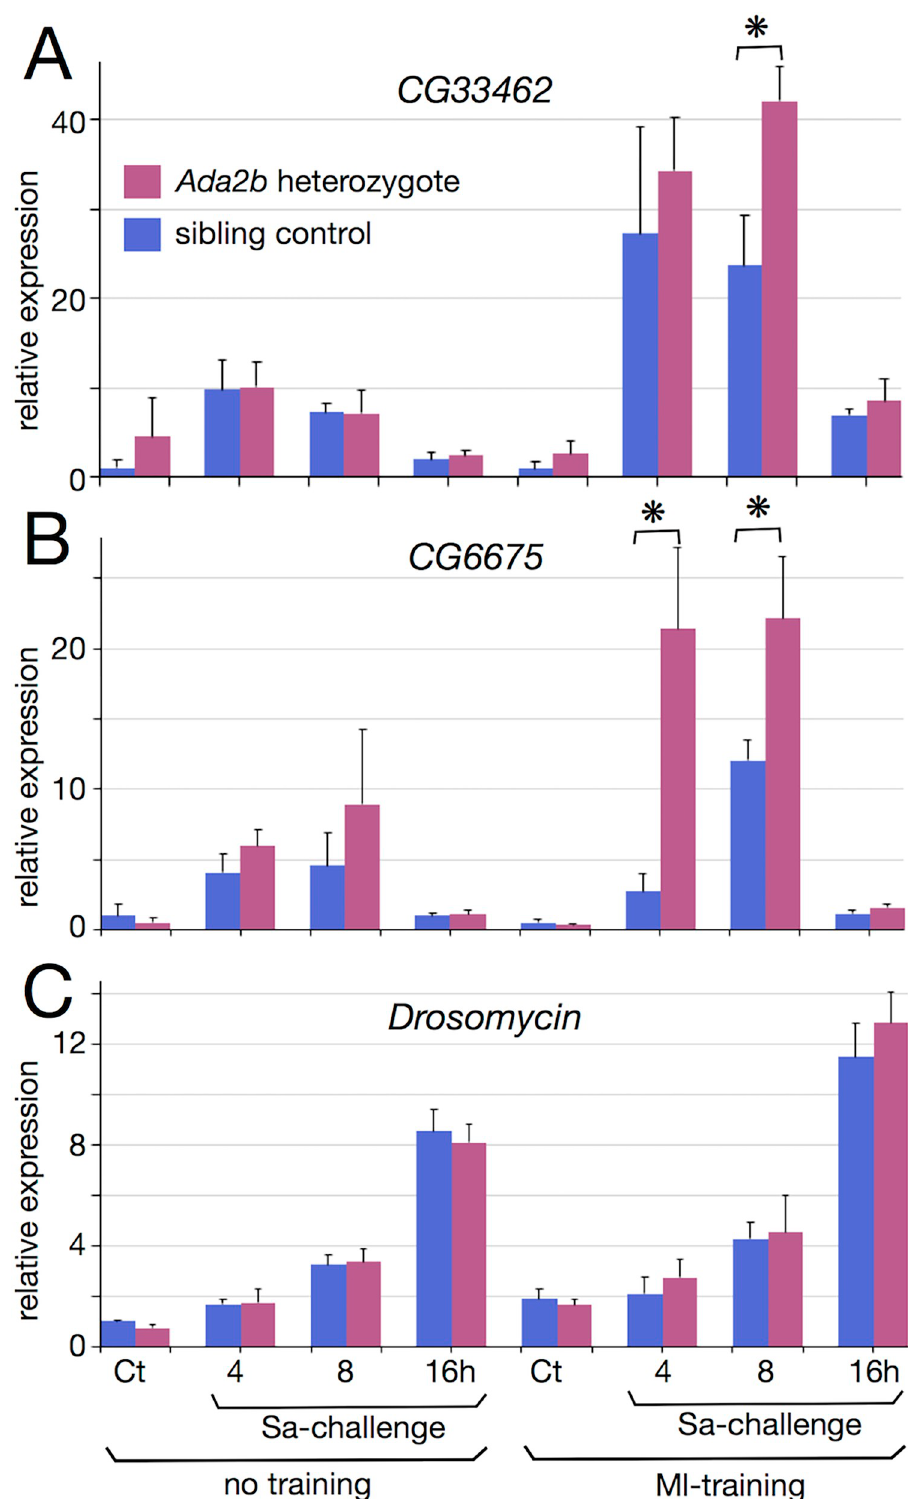
Fig 7. Involvement of Ada2b in gene expression under Ml training. (A-C) RT-PCR analysis measured relative expression of the CG33462 (A), CG6675 (B), and Drosomycin (C) genes (against the RpL32 control gene). Sibling control line ( w ; TM6 / +) (blue bars) and Ada2b heterozygotes ( w ; Ada2b d272 / +) (magenta bars) were injected